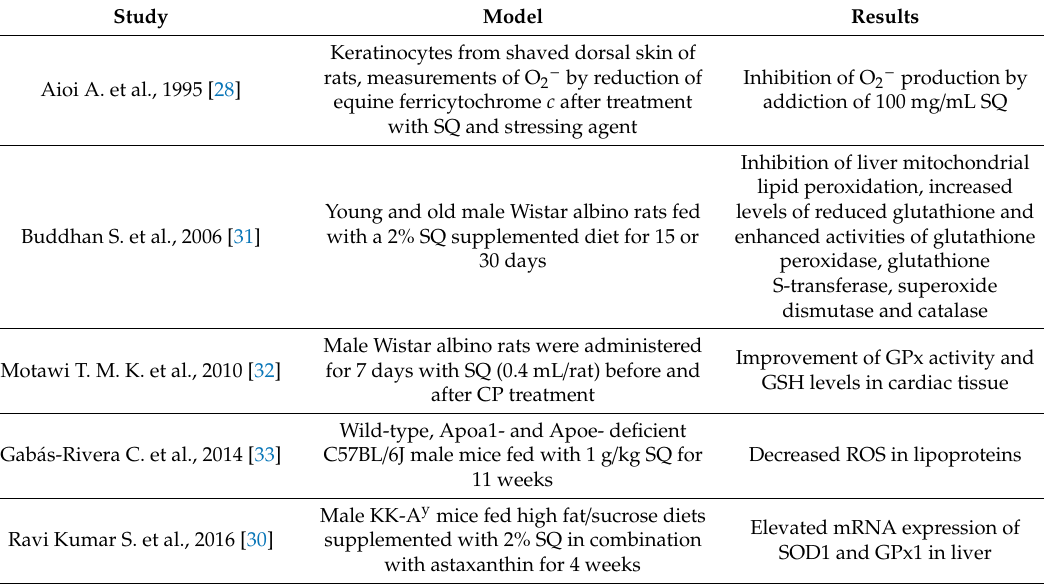
Table1. Principalstudiesshowingantioxidante ff ectofsqualeneinskin,